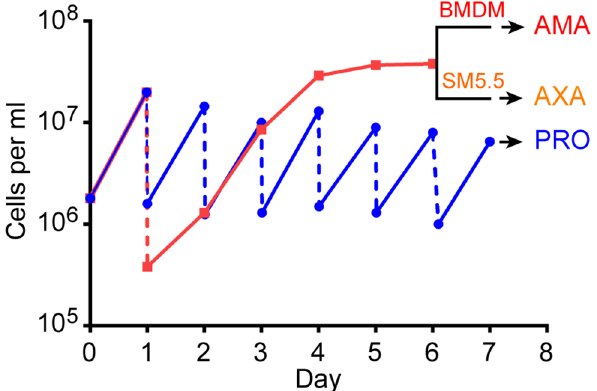
Fig 1. Growth history of cells used for RNA extraction. Data shows growth curve for one of the three replicates. L . mexicana promastigotes (PRO) were maintained in exponential growth by diluting the culture to 1x10 6 cells ml -1 every day (blue line). A second promastigote culture was inoculated with 1 – 2.5x10 5 cells ml -1 and left to grow for five days to stationary phase (red line). Stationary phase promastigotes were used to infect bone marrow derived macrophages (BMDM) to produce intracellular amastigotes (AMA) or differentiated to axenic amastigotes (AXA) in Schneider ’ s medium (SM5.5) for 24h. RNA was extracted from AMA, AXA and PRO on day 7.